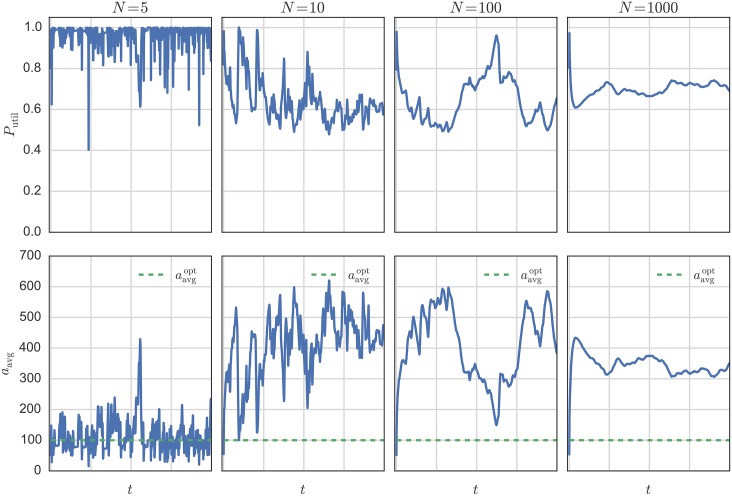
Typical behavior of very small (N = 5), small (N = 10), medium (N = 100) and large systems (N = 1000).The small systems can operate much closer to the optimum, while mid-size systems show big jumps after stable periods. The system parameters are λmin = 0.005, RV = 2Ω, R0 = R/N = 200Ω, perr = 0.01 and V = 1 V. The communication network is configured as a ring.